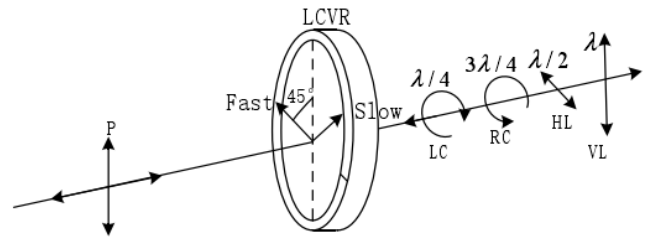
Figure 1. Principle of LCVR polarization imaging.